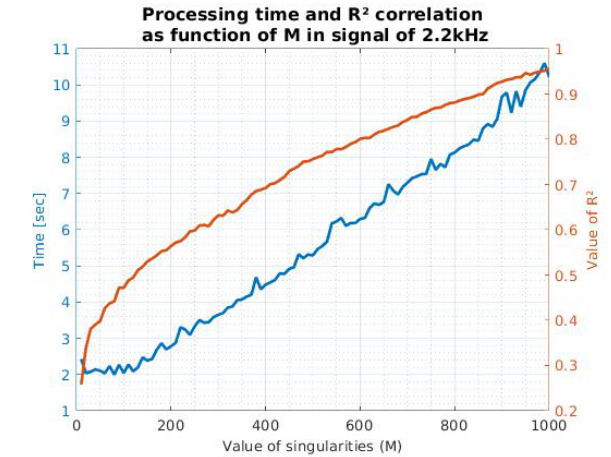
Figure 4. Processing time and correlation coefficient as a function of M, in a bulk carrier ship signal with a sample rate of 2.2